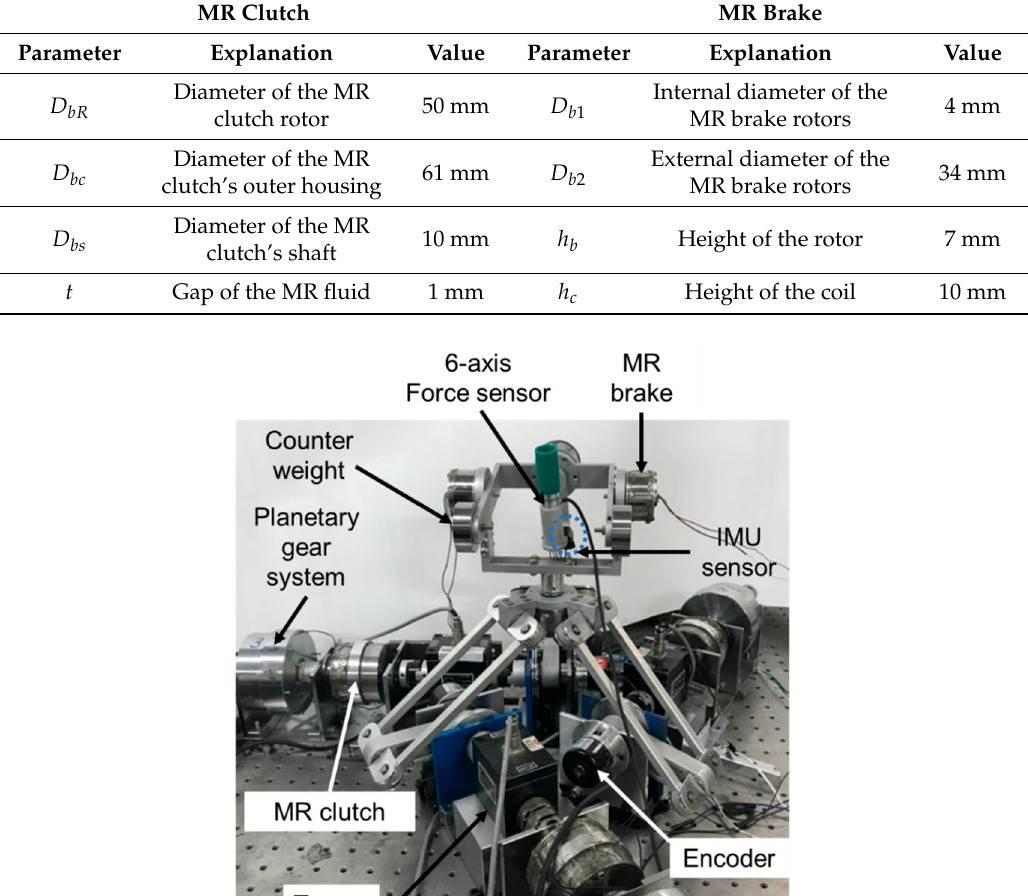
Table 1. Design parameters of the haptic master actuators.